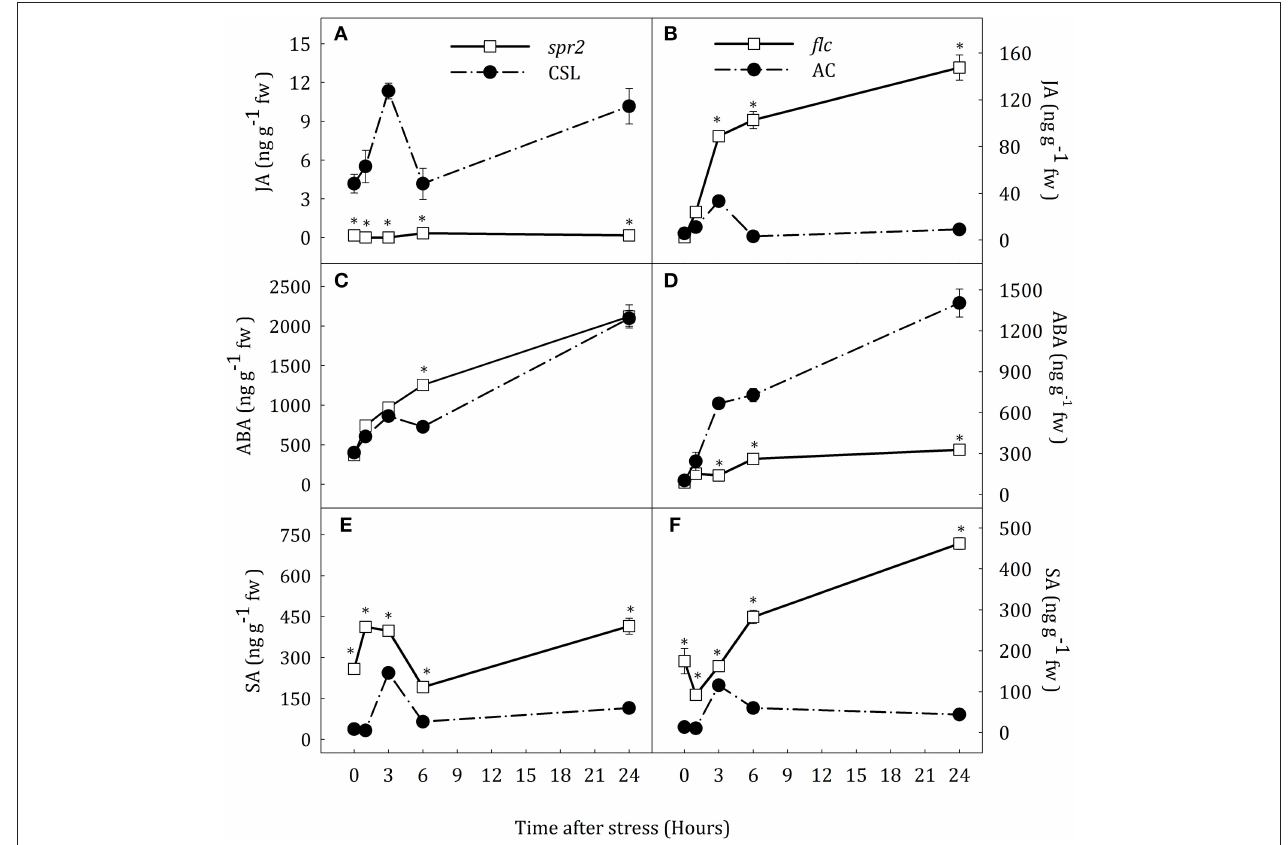
FIGURE 2 | JA (A,B), ABA (C,D) and SA (E,F) endogenous concentrations in leaves of Solanum lycopersicum [WT (CSL and AC, black circles) and mutants ( spr2 and flc , white square)] under control ( t = 0 ) and water-stress conditions. Data are mean values ± standard deviation of three independent determinations. Asterisks denote statistical difference with respect to WT at p ≤ 0.05